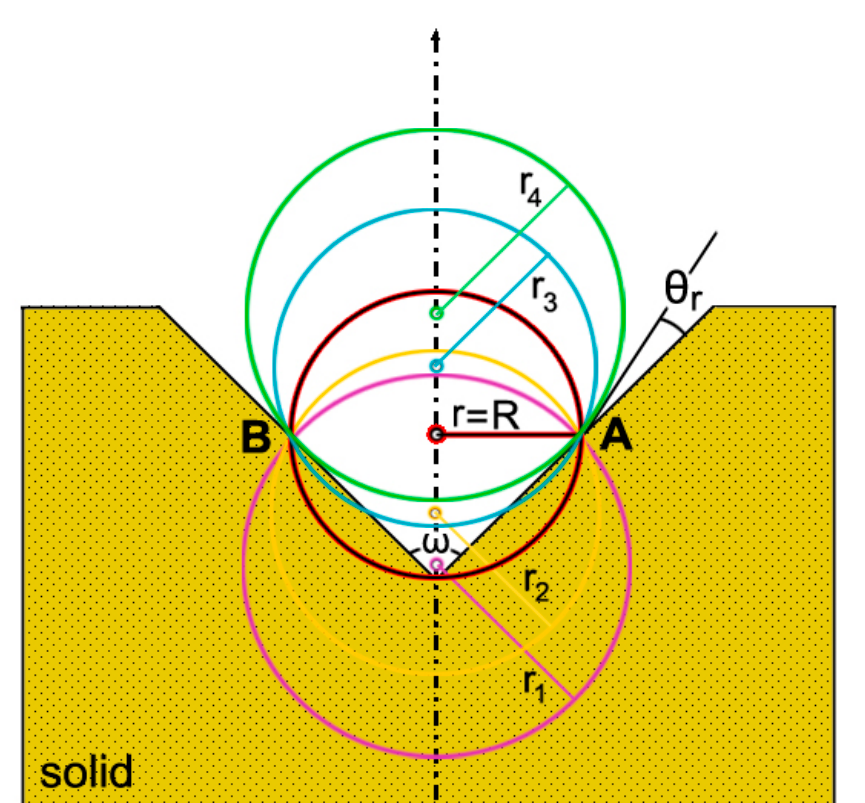
Figure 3. A bubble impended in a crevice. The course of events ∆ p increases, where r is the radius of curvature, θ r is the receding angle (small), and R is the pinning half distance between Points A and B. When r = R, the bubble is hemispherical.